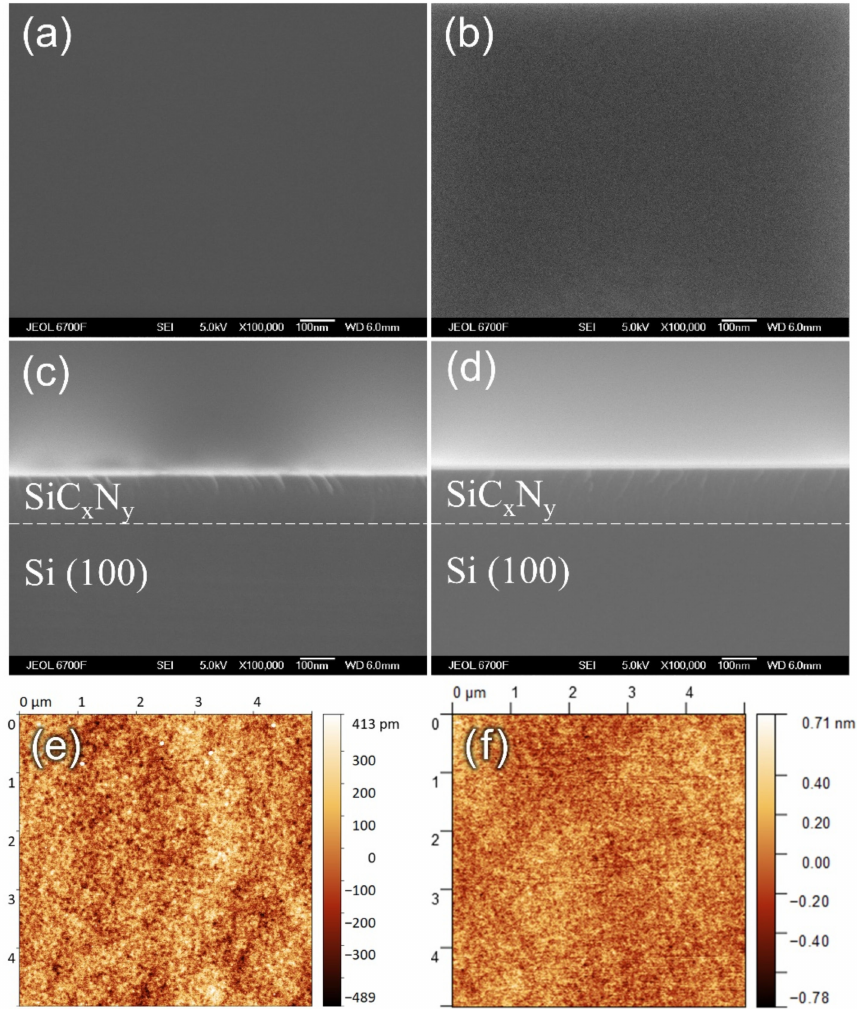
Figure 3. SEM images: top view of SiC x N y film prepared at RT and ( a ) 0, ( b ) 30 sccm of nitrogen flow rate; cross-section view for ( c ) 0, ( d ) 30 sccm and AFM images for ( e ) 0, ( f ) 30 sccm flow rate (series